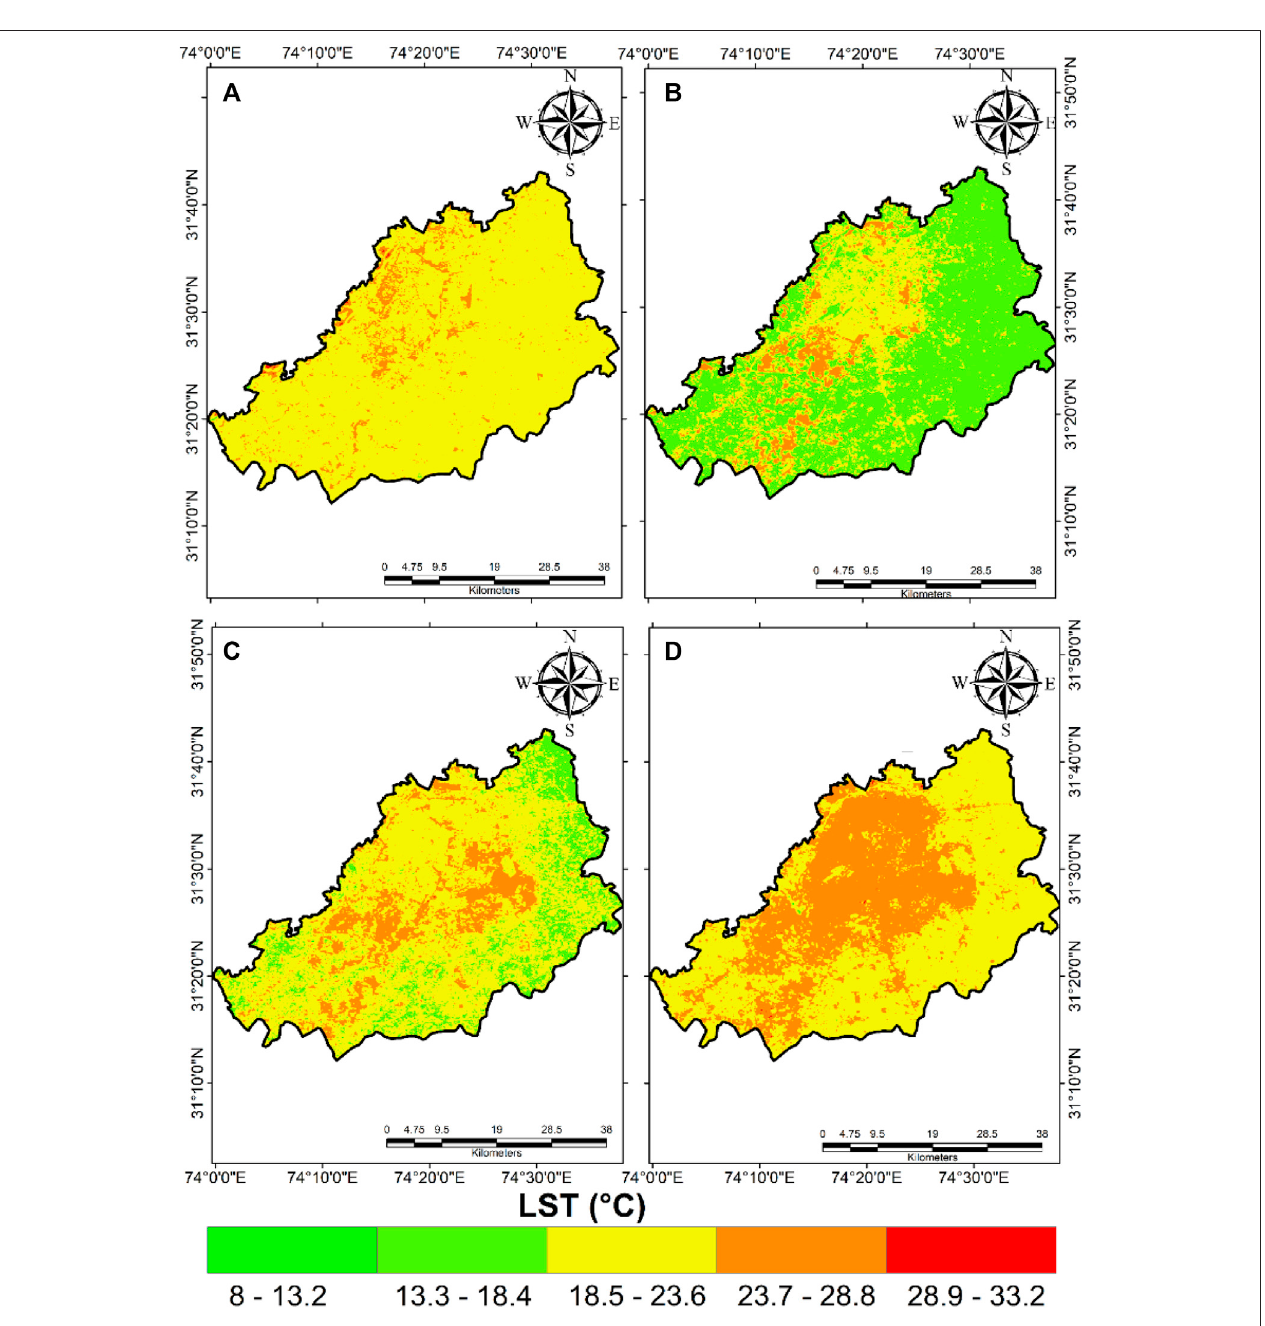
FIGURE 5 | Land surface temperature for the years (A) 1990, (B) 2000, (C) 2010, and (D) 2020.